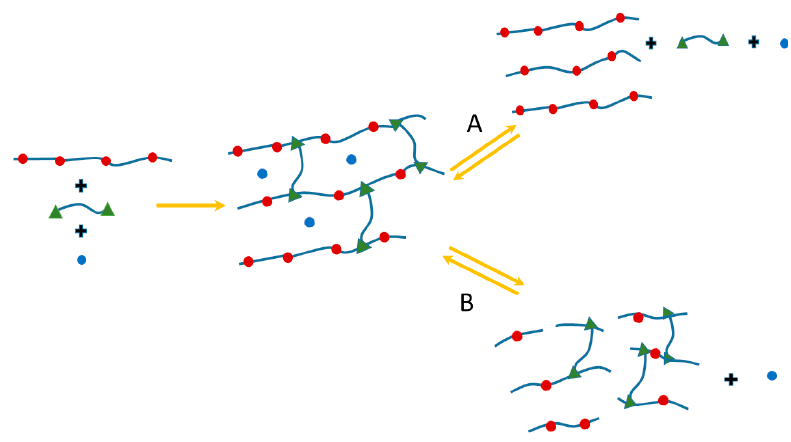
Figure 3. Schematic diagram for the strategy behind the use of reversible covalent bonds in hydrogels. ( • ) = reversible bonds along the backbone; ( ∆ ) = reversible bonds as crosslinking points; ( • ) = loading of the network (substrate).